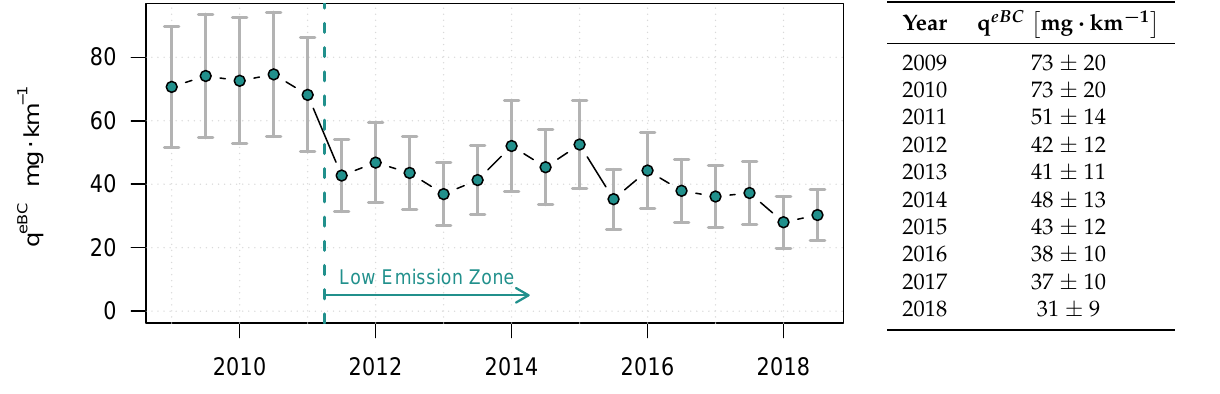
Figure 7. Left : eBC emission factor for the station EIBA as summer/winter averages 2009–2018 from 6-month scatter plots. Error bars indicate 95% confidence interval of the fit plus 25% measurement uncertainty (see discussion). Right : Table with the yearly fitted eBC emission